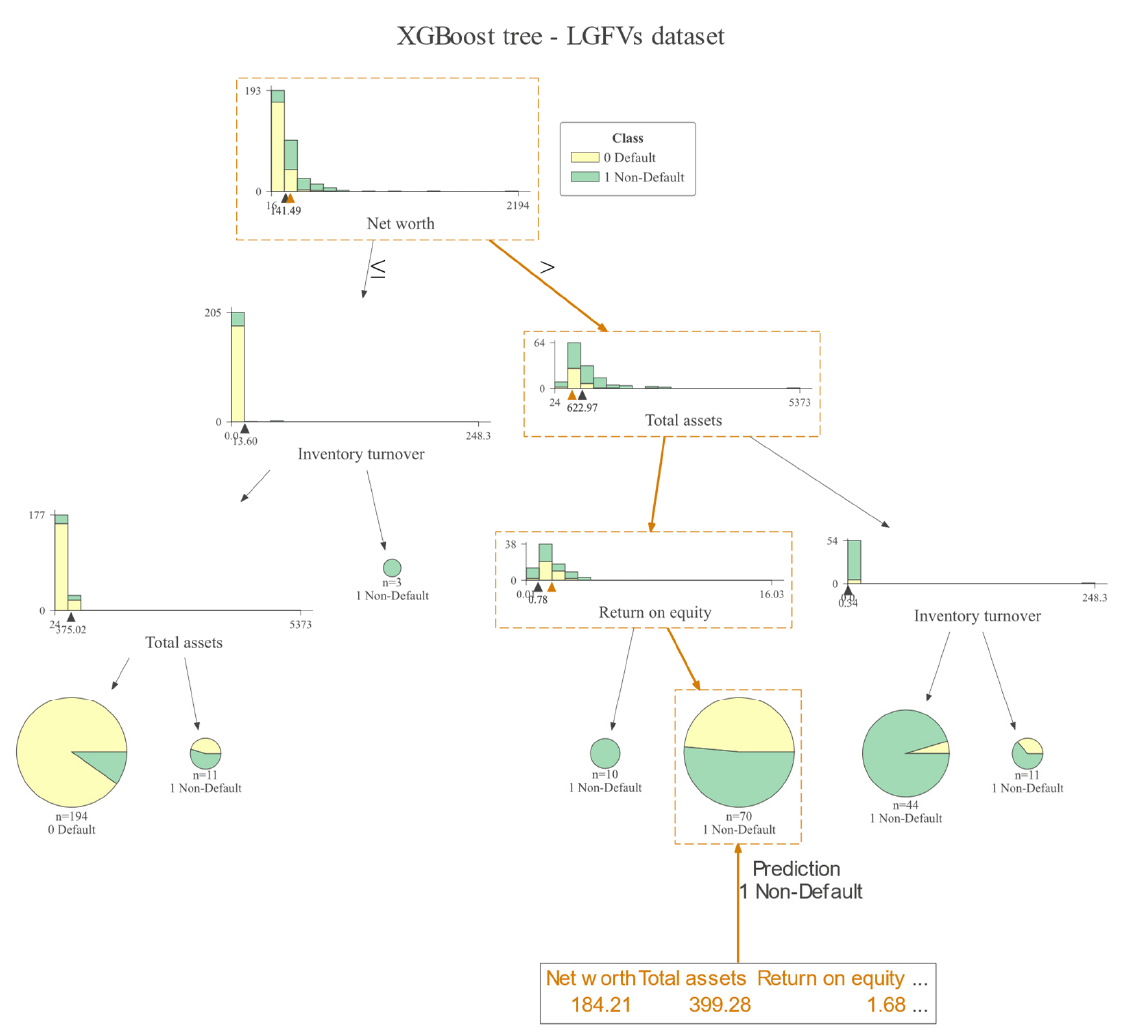
Figure 10. Visualization case of the XGBoost decision training model.